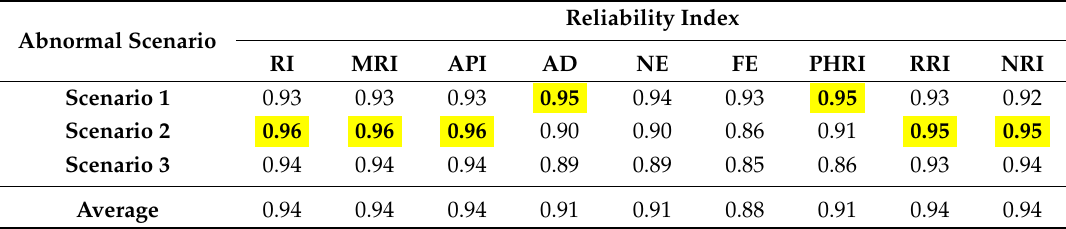
Table 7. Correlation coe ffi cients obtained by scenario-based